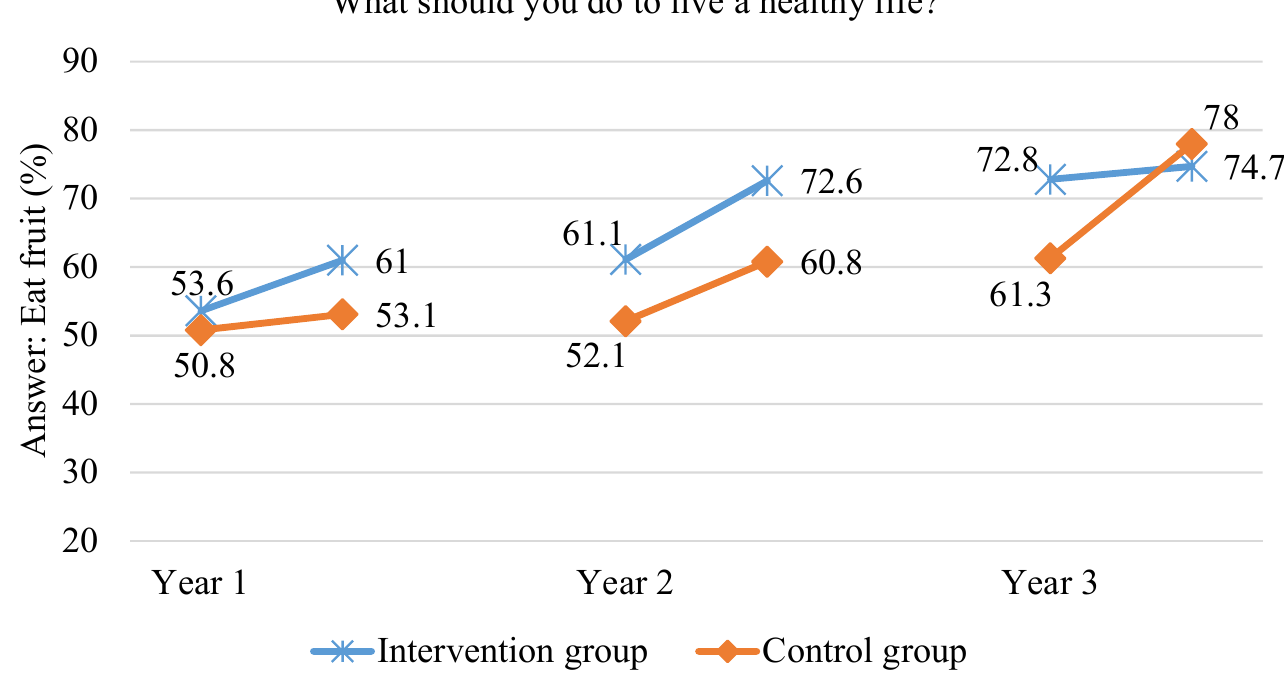
Figure 5. Proportion of children indicating fruit consumption as a health-supporting behaviour during the three years of the study.